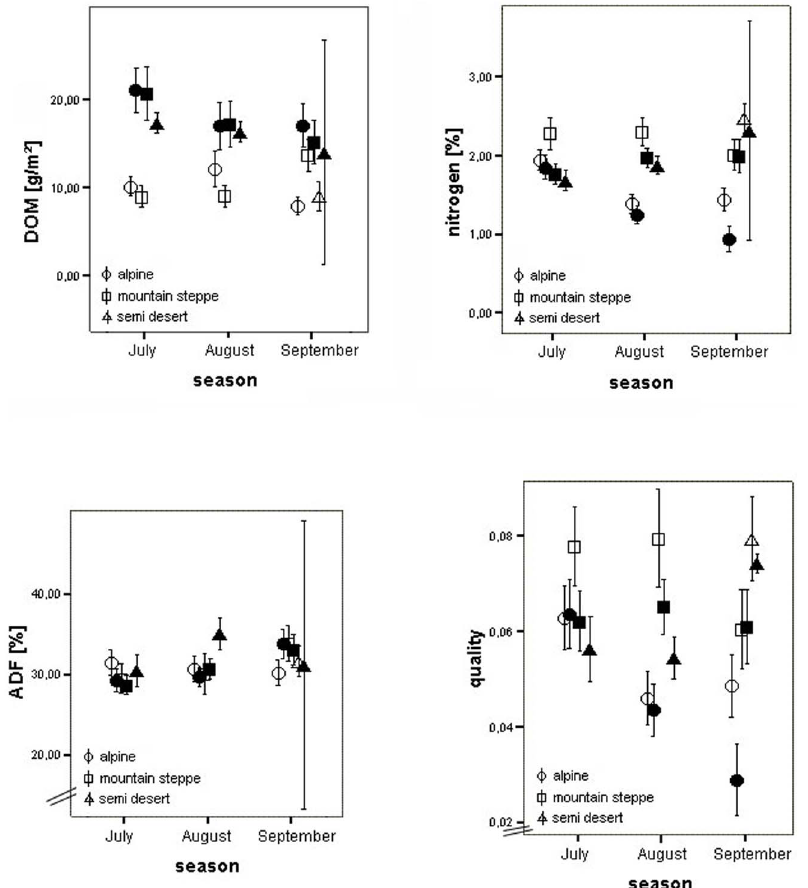
Figure 4. DOM, nitrogen, ADF and quality (N/ADF) of vegetation of 1 m 2 plots in relation to ecotype, season and distance class of study sites. Error bars indicate the 95% confidence interval of the mean. Empty symbols=sites close to rivers, filled symbols=sites away from rivers. Data for the semi-desert were not assigned to close or distant sites.